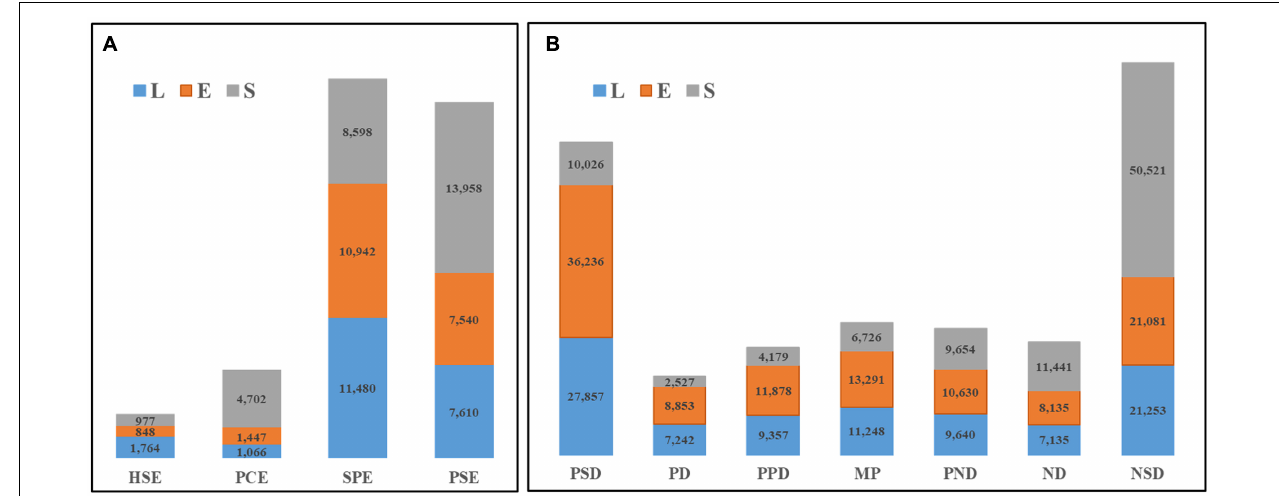
FIGURE 2 | Gene expression pattern in hybrids. Qualitative changes (PAVs) and quantitative changes (PHCE) in gene differential expression were represented in panels (A,B) , respectively. The numbers in the bars represent the DEGs in different gene expression types (horizontal classification), and the different colors indicate that each tissue part is listed in the